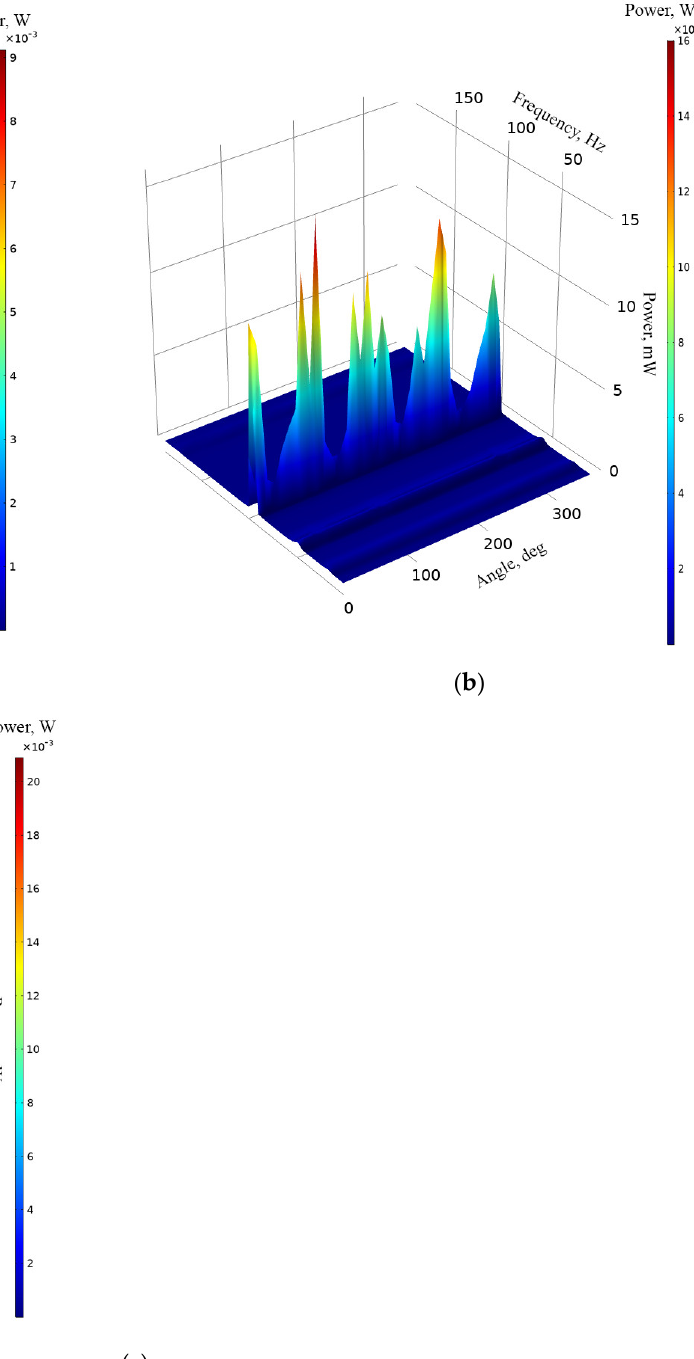
Figure 10. Frequency—power—and angle of excitation motion characteristics of the energy harvester with different loads; ( a )—load equal to 1 MΩ; ( b )—load equal to 500 kΩ; ( c )—load equal to 250 kΩ.